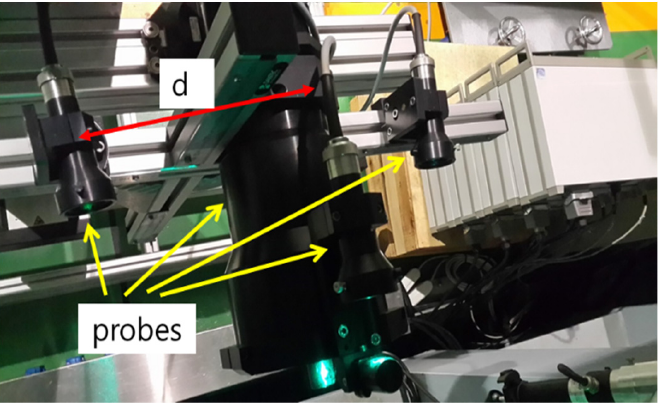
Figure 7. LDV probes and spacing d between main and side wing probes.